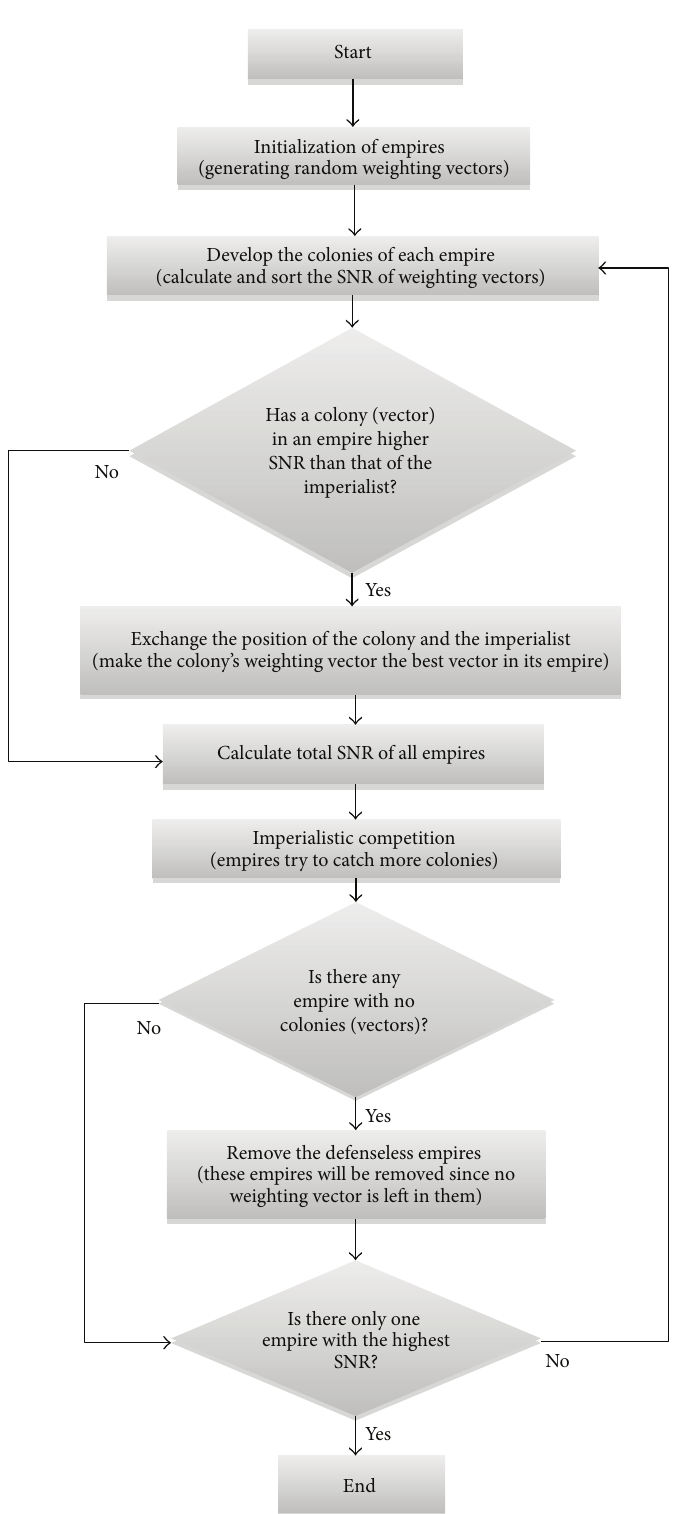
Figure 3: ICA-based flowchart that maximizes the quality of the received signal in diversity combining